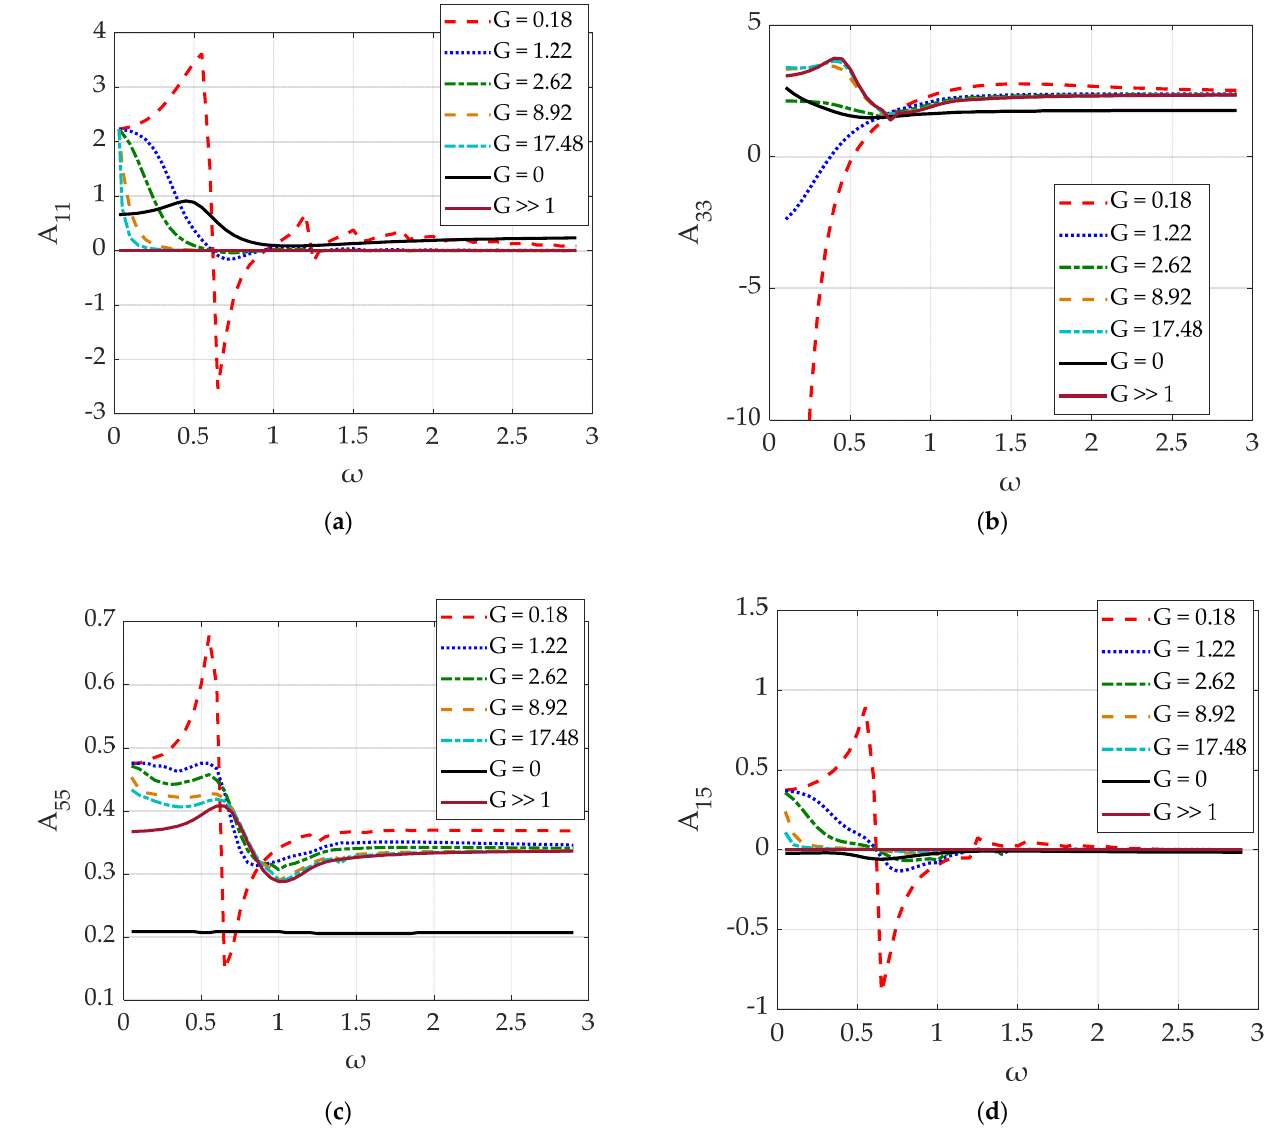
Figure 6. Dimensionless hydrodynamic added mass A 11 ,A 33 , A 55 , A 15 of the permeable cylindrical body against wave frequency ω for various values of porous effect parameter: ( a ) A 11 ; ( b ) A 33 ; ( c ) A 55 ; ( d ) A 15 . The results are also compared with the corresponding ones of a truncated cylinder ( G = 0 case) and of a submerged cylindrical plate ( G (cid:29) 1